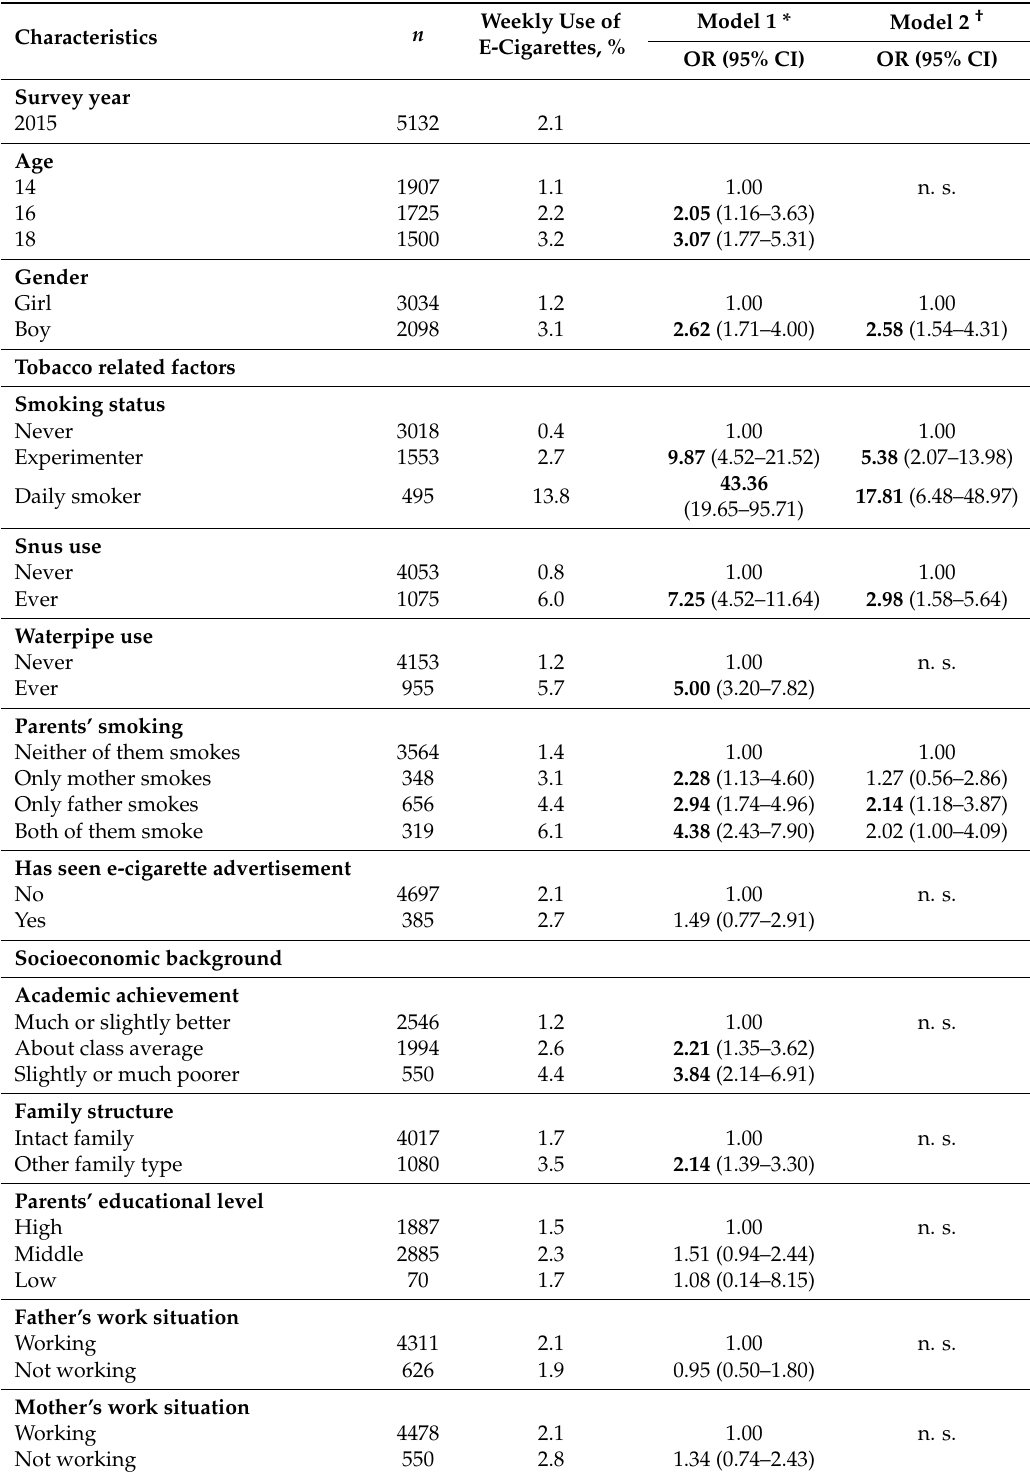
Table 4. Age and gender adjusted prevalence (%) of e-cigarette weekly use and odds ratios (OR) and the 95% confidence interval for e-cigarette use by gender and tobacco related and socioeconomic factors, among 14–18-year-olds in